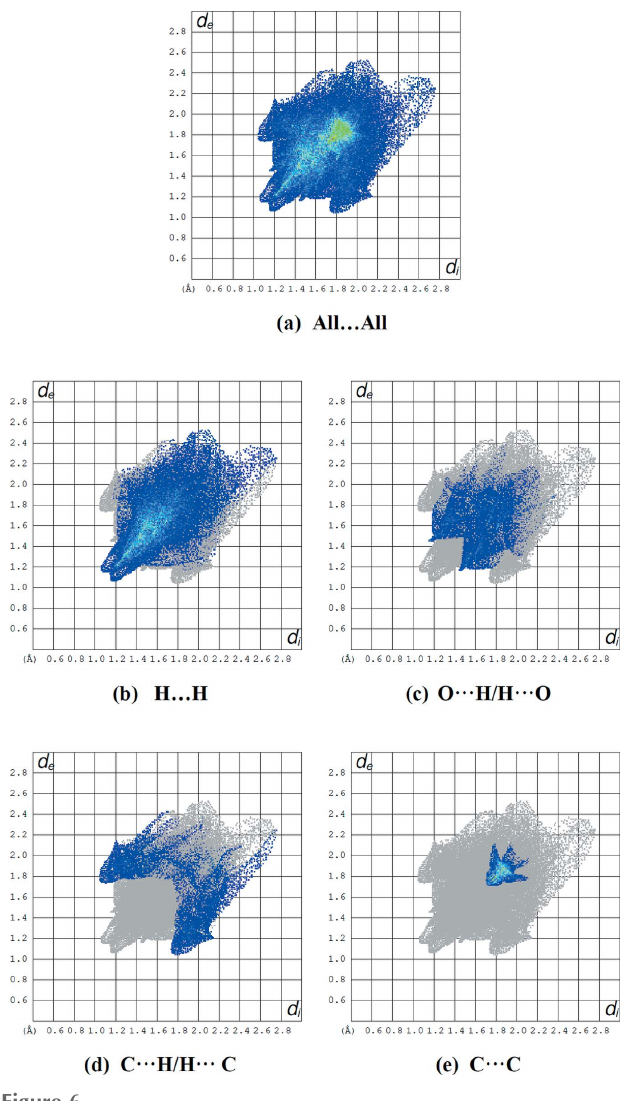
Figure 6 Fingerprint plots showing ( a ) all intermolecular interactions and delineated into ( b ) H (cid:2)(cid:2)(cid:2) H, ( c ) O (cid:2)(cid:2)(cid:2) H/H (cid:2)(cid:2)(cid:2) O, ( d ) C (cid:2)(cid:2)(cid:2) H/H (cid:2)(cid:2)(cid:2) C and ( e ) C (cid:2)(cid:2)(cid:2) C